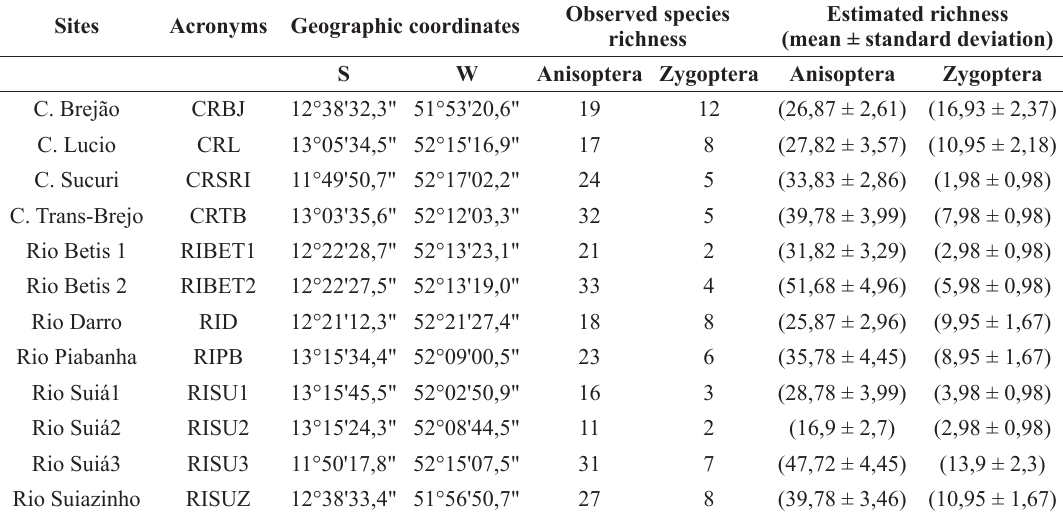
Sites sampled and their acronyms, geographic coordinates, and species richness for the sites sampled and the suborders Anisoptera and Zygoptera at the Suiá-Missú River Basin,